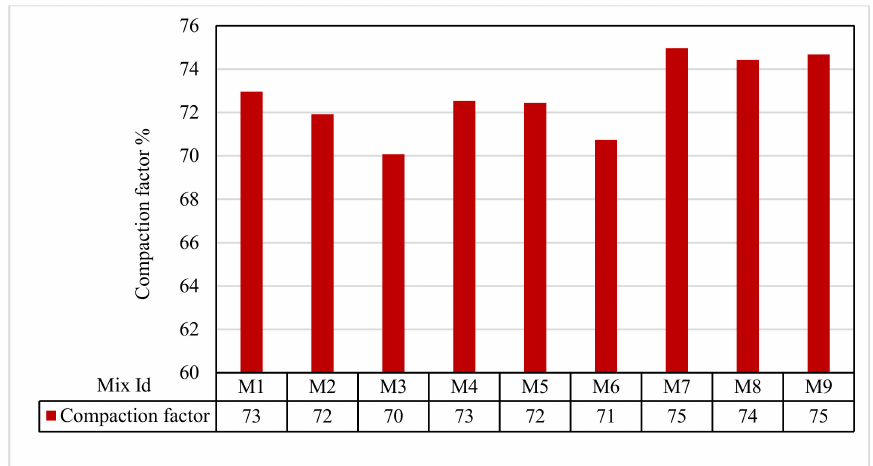
Figure 6. Compaction factor test